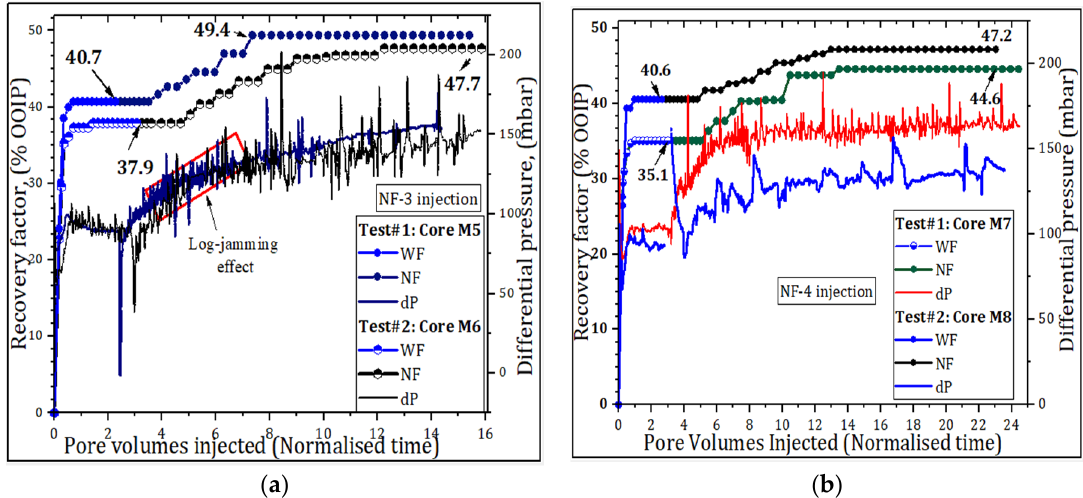
Figure 5. Influence of nanoparticles on oil recovery and on differential pressure: ( a ) water flood oil recovery in cores M5 and M6 was 40.7% and 35.9% OOIP, respectively; after nanofluid “NF-3”, the recovery was 49.4% and 47.7% OOIP. ( b ) In cores M7 and M8, WF recoveries were 35.1% and 40.6% OOIP, respectively; after nanofluid “NF-4” injection, they increased to 44.6% and 47.2% OOIP, respectively. Table 3. Oil recovery factors (expressed as % of the original oil in place (OOIP)) and residual oil saturation achieved at the end of core flood tests.